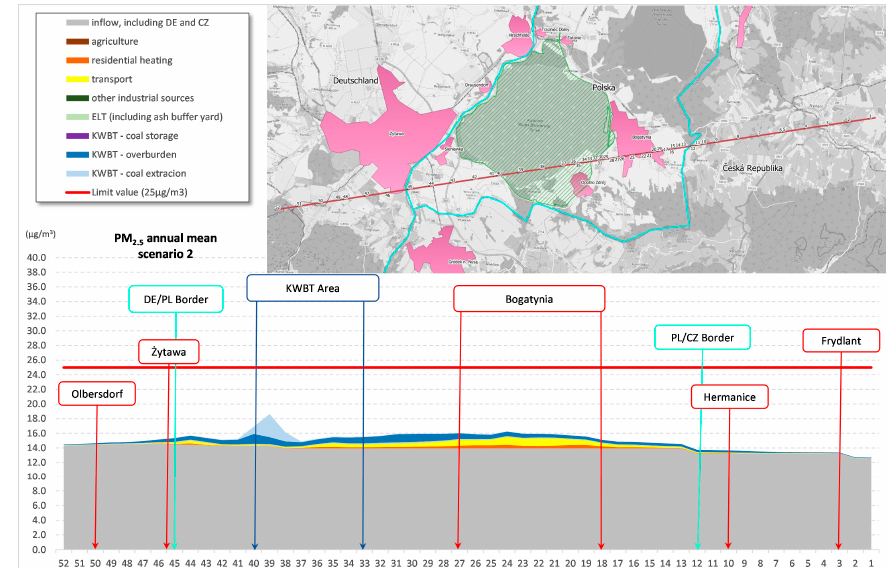
Figure 25. Profile of annual mean concentrations of PM 2.5 between Olbersdorf and Frydlant, considering the shares of individual source groups in scenario 2 (source: own study).